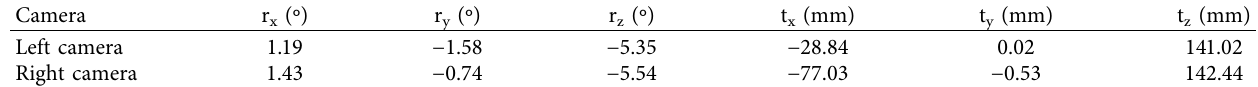
Table 1: Extrinsic parameters of left and right cameras.